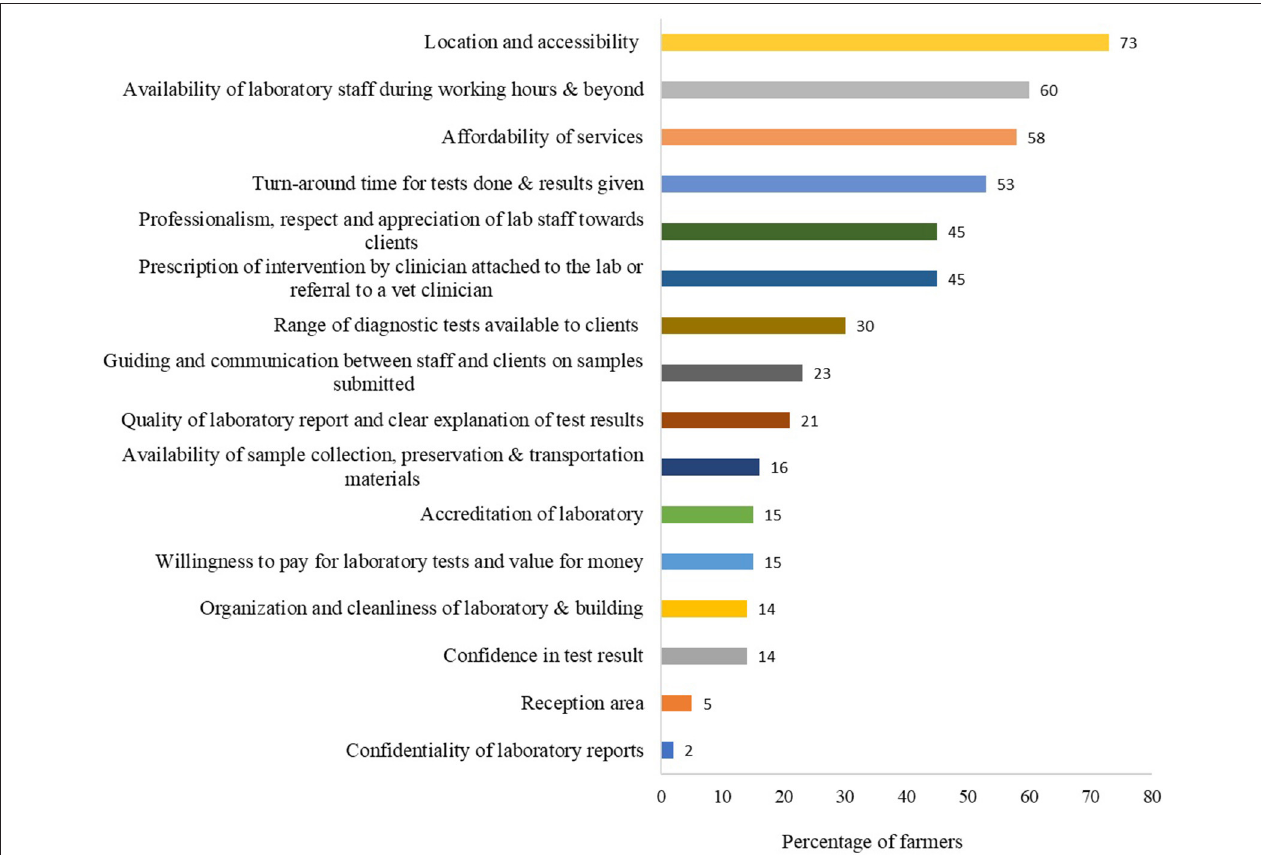
FIGURE 8 | The Top ranked important factors that determine whether farmers would submit samples to a laboratory or not. Bars represent percent of farmers ( n = 86) that selected each factor. This question had multiple